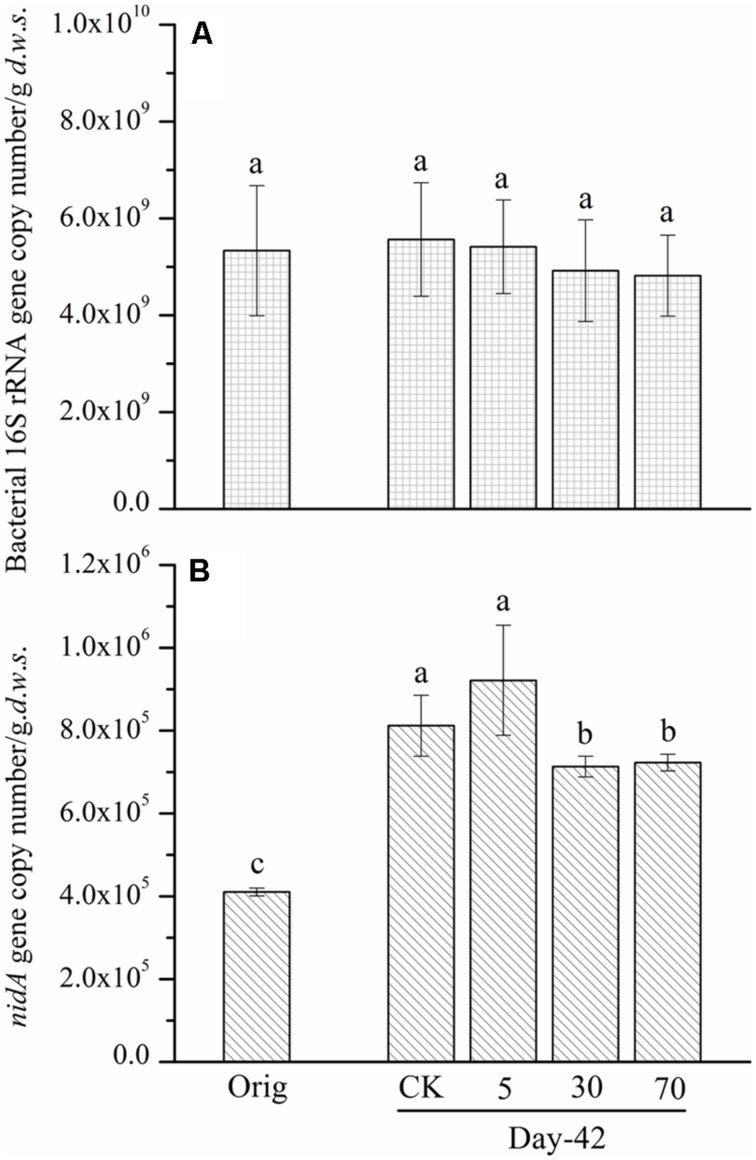
Bacterial 16S rRNA gene (A) and nidA gene (B) copy number determined by real-time PCR from soil microcosms. The designation Orig denotes the original soil that did not receive any treatment. The designation control denotes the control soil that was treated with acetone. The designations 5, 30, and 70 refer to the soils that were treated with acetone-dissolved pyrene at concentrations of 5, 30, and 70 mg ⋅ kg-1
d.w.s. Same letters indicate no significant differences by Duncan’s multiple range test (P < 0.05). The error bars represent the SD of the means of triplicate microcosms.